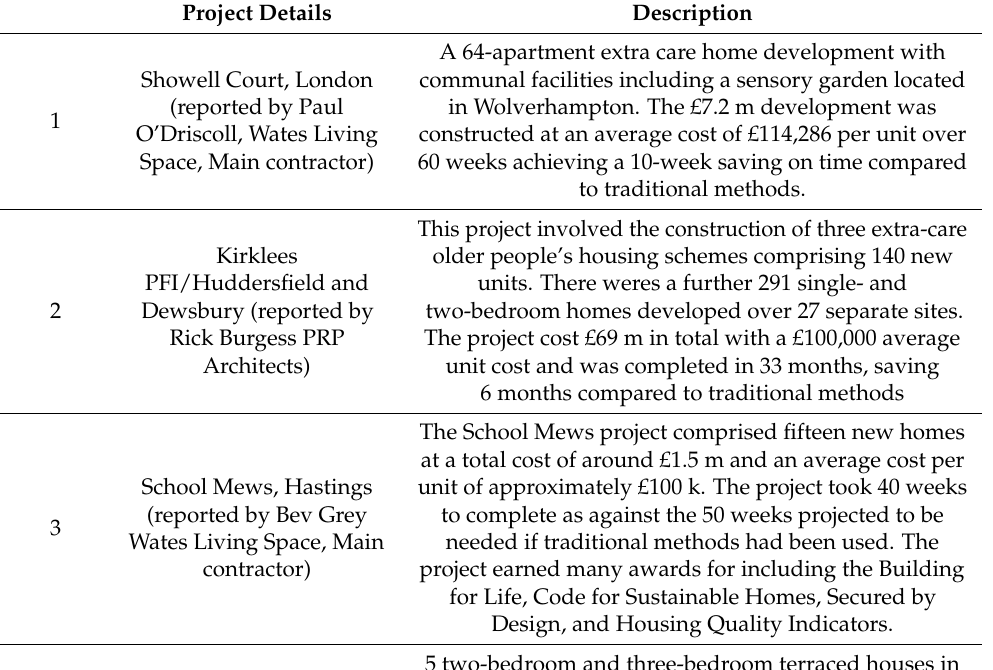
Table 1. Details of the case studies Source: